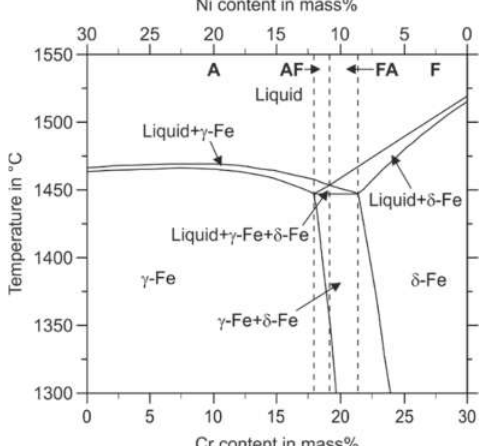
Figure 7. Pseudobinary section of the phase diagram of the alloying system Fe–Cr–Ni at 70 mass% Fe calculated using ThermoCalc.